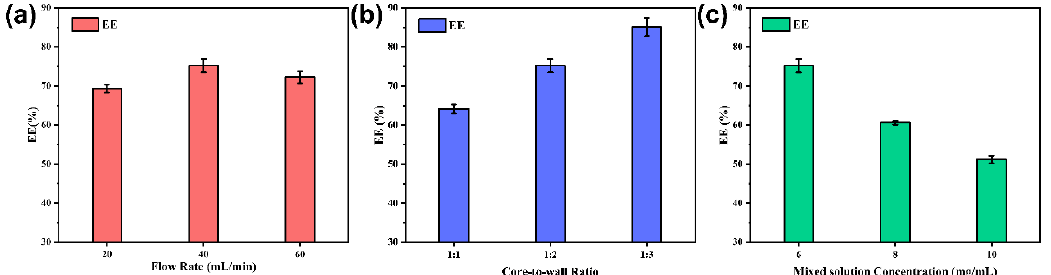
Figure 9. Encapsulation efficiency of nanocapsules at different flow rates ( a ) at different core-to-wall ratios ( b ) at different concentrations of mixed solutions ( c ).